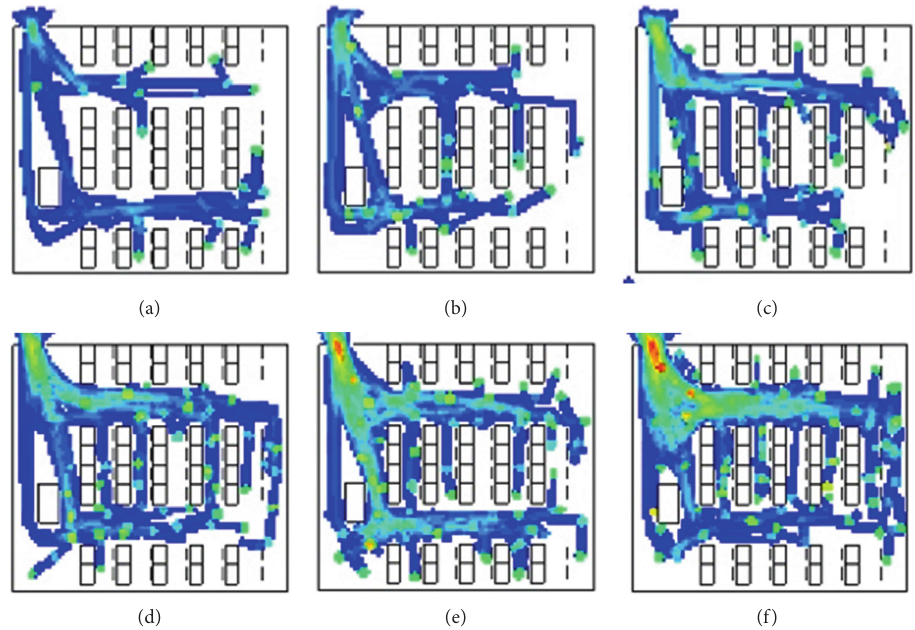
Figure 11: Flow size-based space use rate under disorderly distribution conditions. The space utilization illustrates the space using of pedestrians in an emergency. (a) 10. (b) 15. (c) 20 (d) 25. (e) 30. (f) 35.